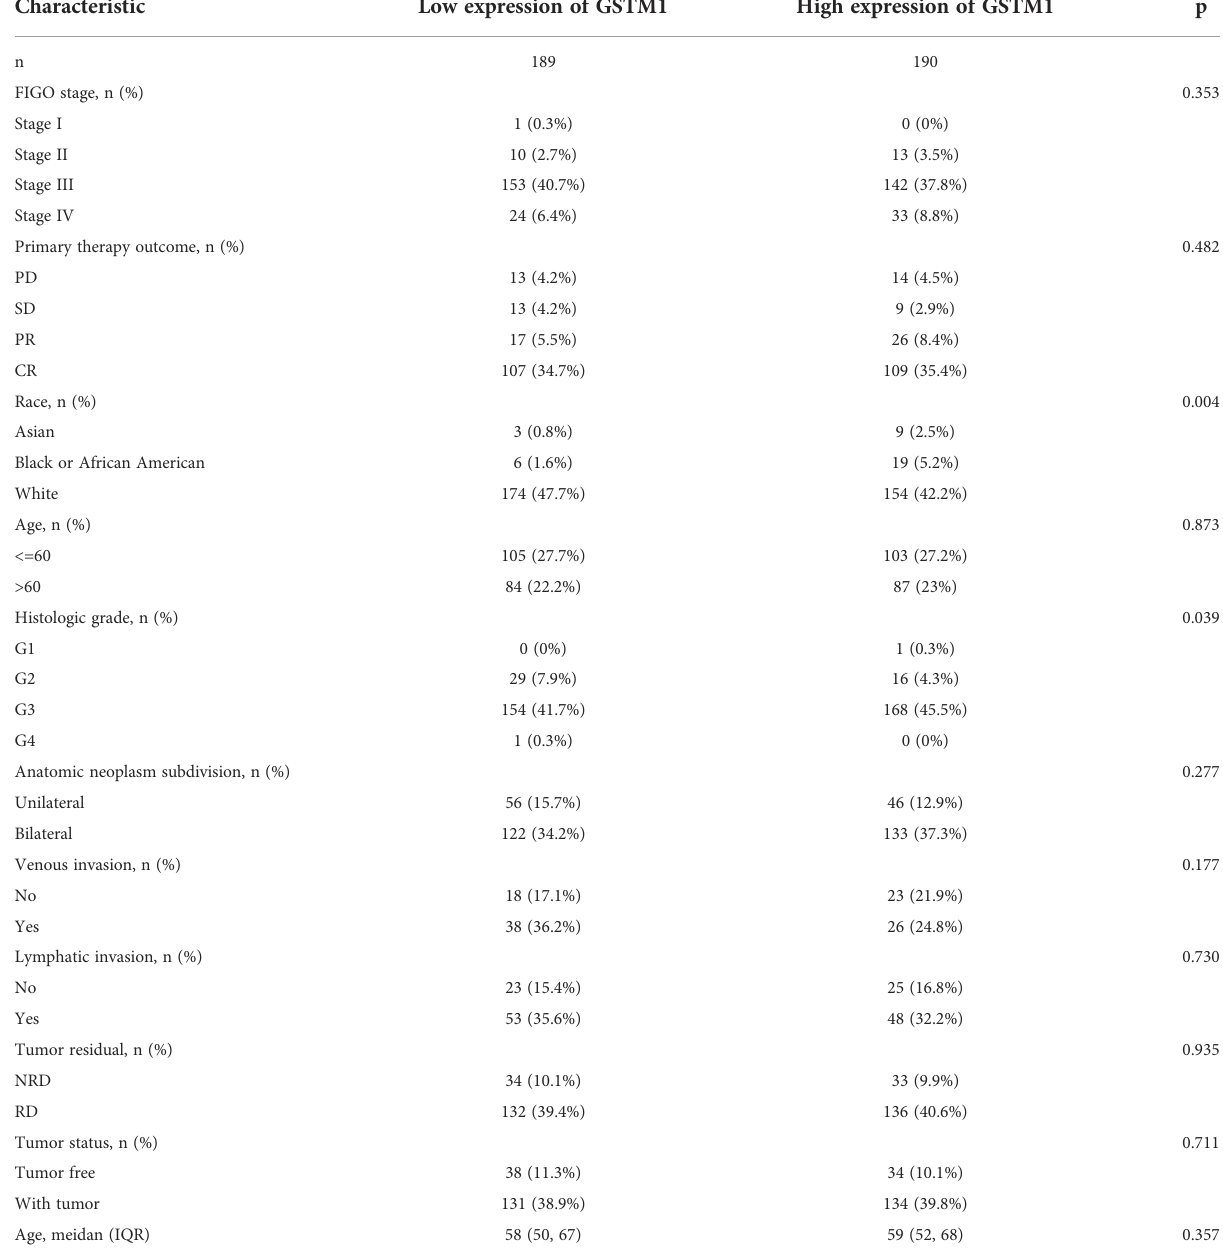
TABLE 1 The correlation between pathological parameters and GSTM1